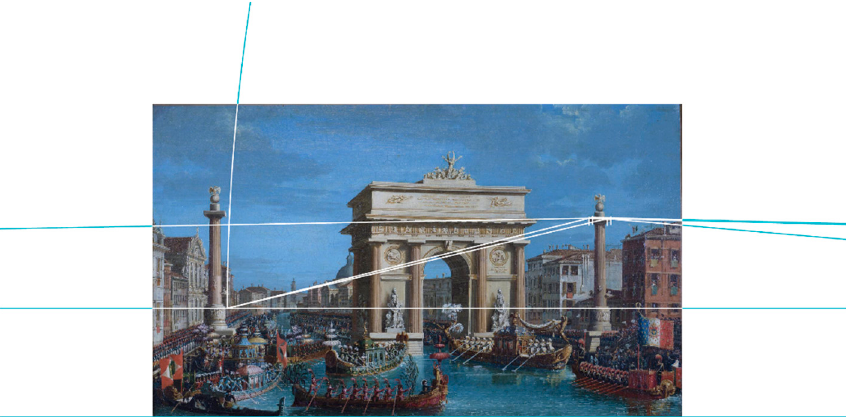
Figure 11. The construction of geometric system necessary to determine the internal orientation of Borsato’s painting. Borsato’s